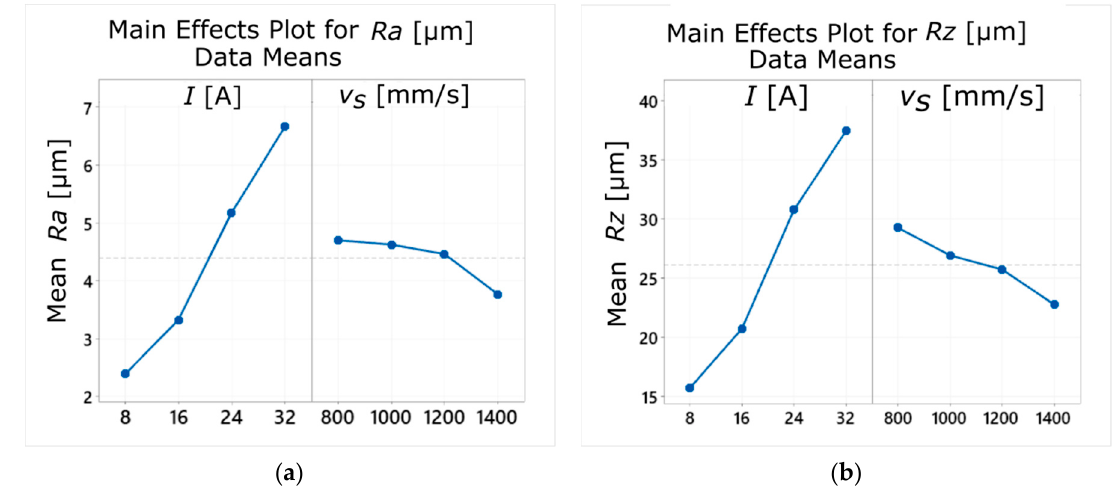
Figure 6. Influence of the process parameters ( I and v s ) on the values of surface roughness parameters: ( a ) Ra and ( b ) Rz .